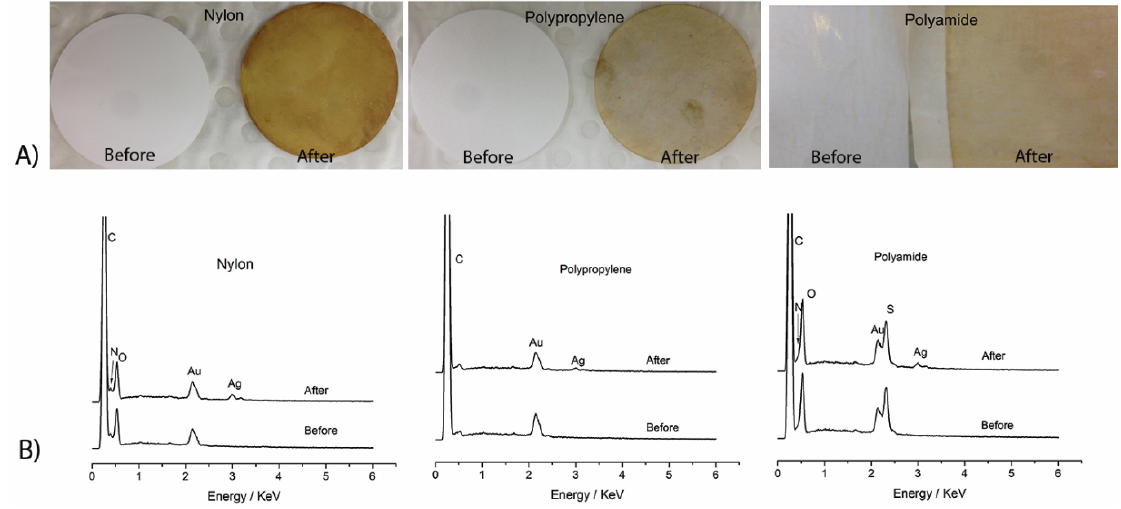
Figure 6. The surface color ( A ) and SEM-EDS ( B ) of nylon, polypropylene (PP), and polyamide membranes before and after silver immobilization.